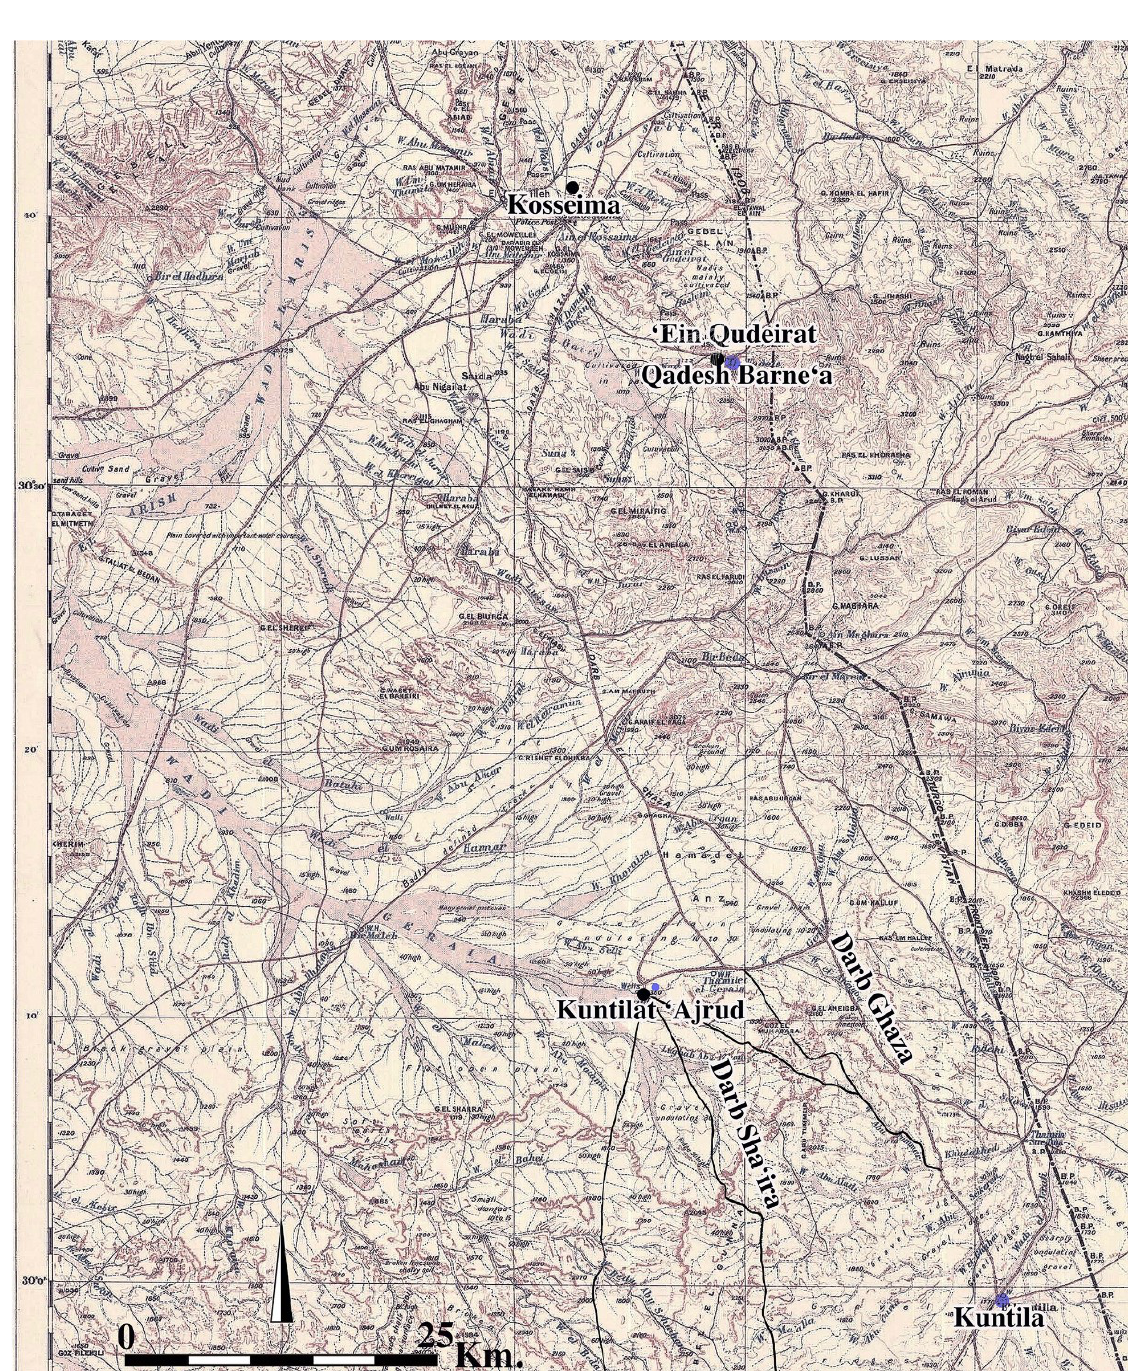
Figure 9 A section of the Newcomb Map (1914) showing the (ancient) road network around Kuntilat